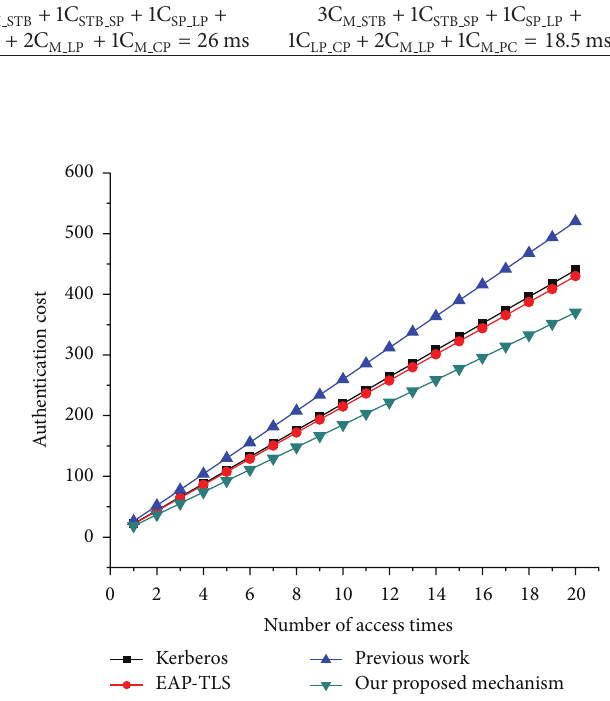
Figure 9: Accumulated authentication cost versus the number of times mobile users access the